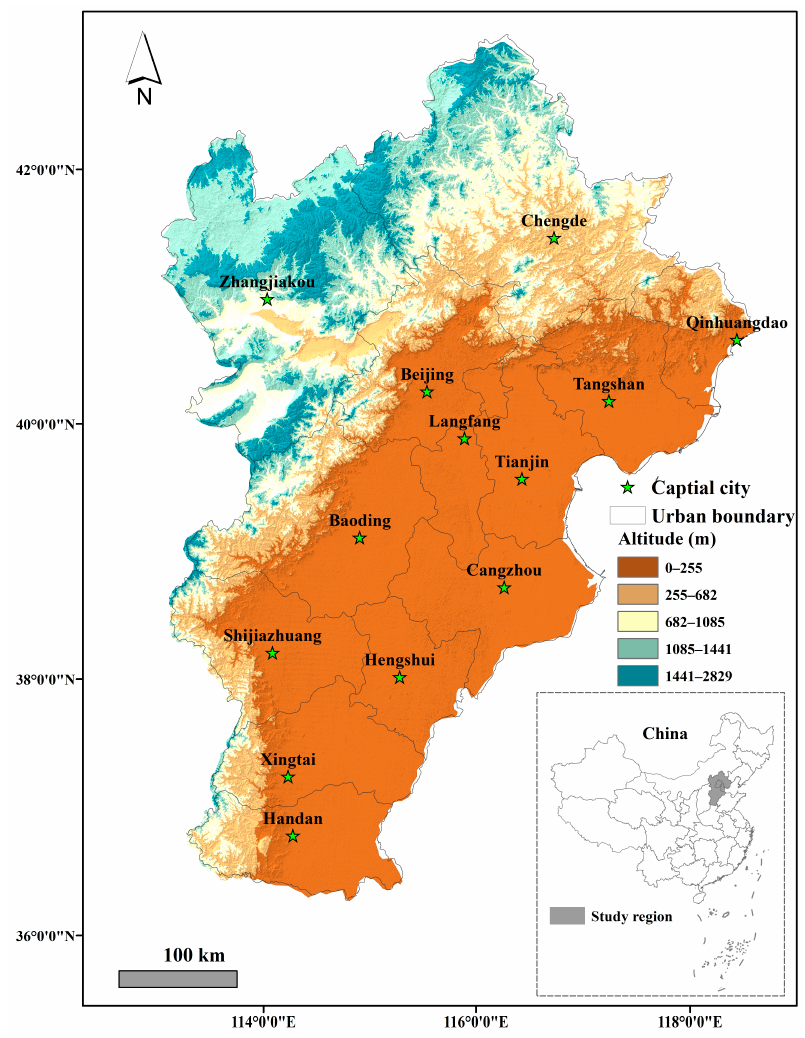
Figure 1. Figure 1. The spatial location of the Beijng–Tianjin–Hebei (BTH)